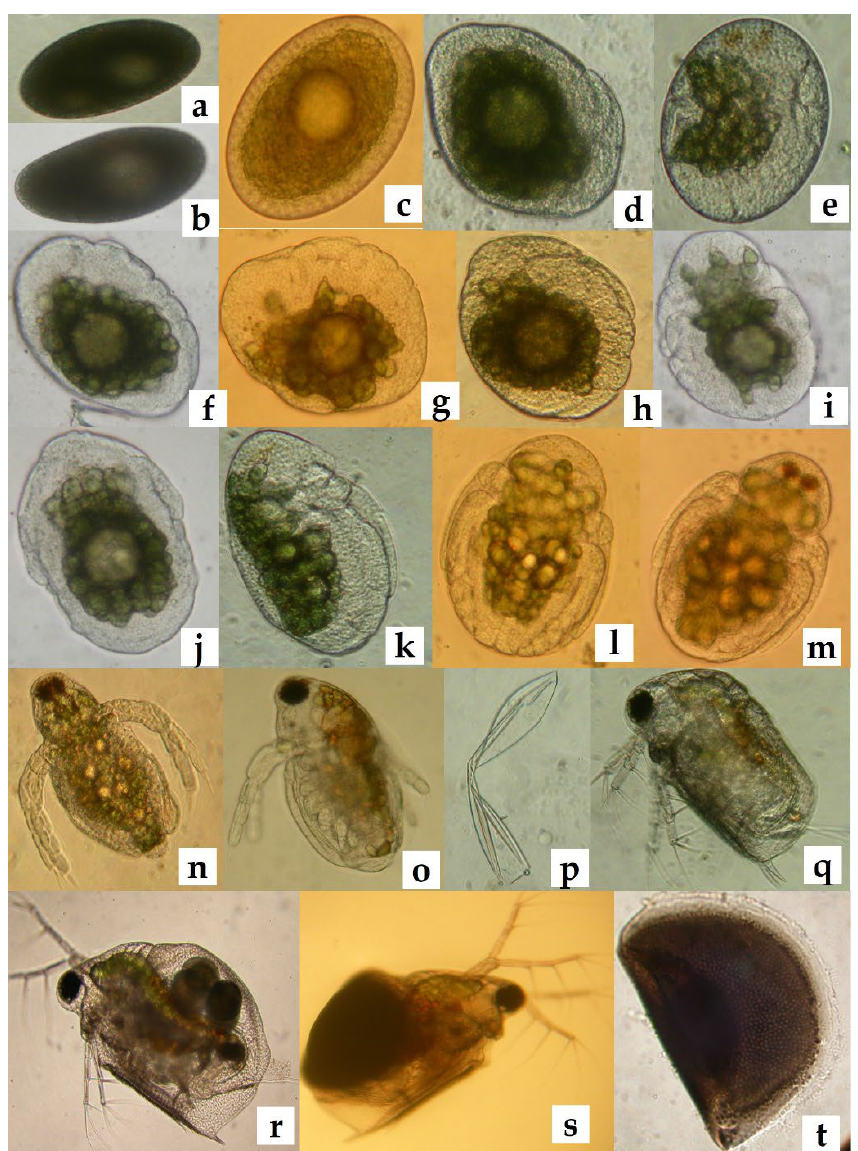
Figure 3. The process of embryonic development of S. mucronata . ( a,b ) One-cell stage; ( c ) membrane lift; ( d ) 2-cell stage; ( e ) 4-cell stage; ( f ) 8-cell stage; ( g ) multicell stage; ( h ) blastula stage; ( i ) gastrula stage; ( j ) formation of “T”-type embryo; ( k ) formation of antenna rudiment; ( l ) formation of pereiopod rudiment; ( m ) formation of 2 compound eyes; ( n ) single compound eye stage; ( o,p ) membrane rive; ( q ) expulsion from matrix; ( r ) parthenogenetic female; ( s ) ephippial female; ( t ) ephippium.